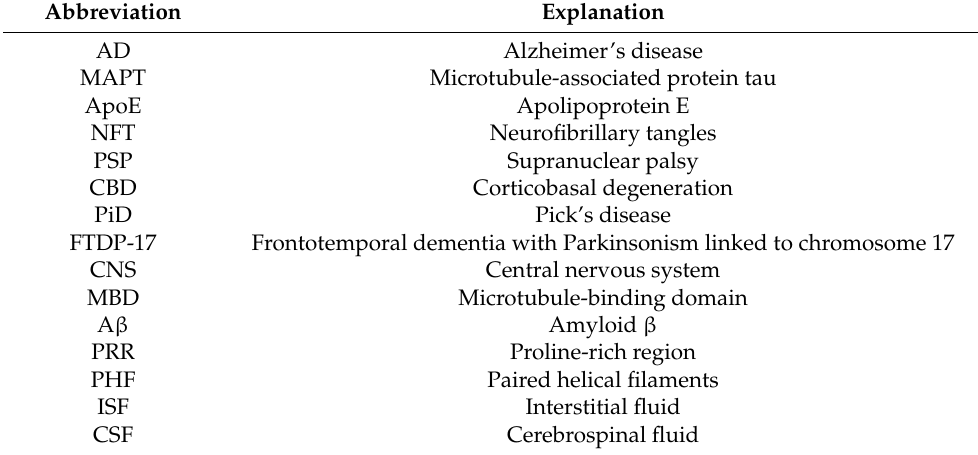
Table 1. Table of abbreviations used in this